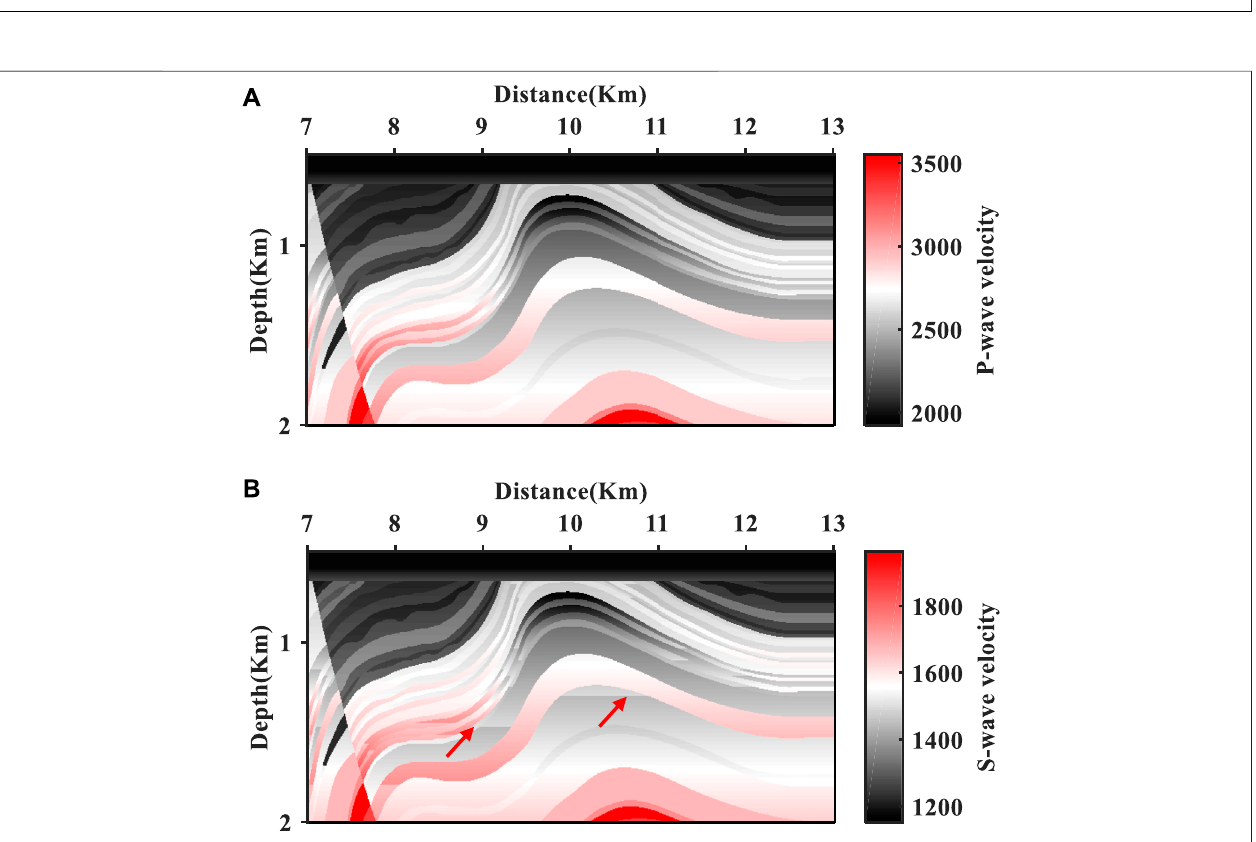
FIGURE 17 | The partial enlargements of the P-wave velocity of the elastic Marmousi 2 model (A) and the S-wave velocity of the elastic Marmousi 2 model (B) .